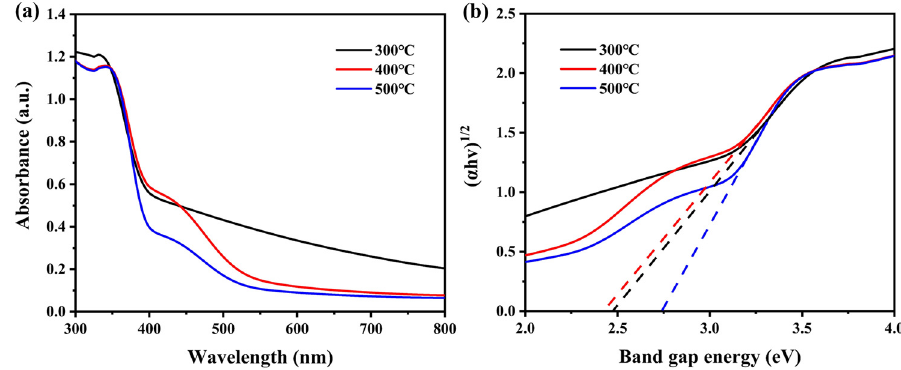
Figure 3. ( a ) UV-visible absorption spectra of N-TiO 2 prepared under three different calcination temperatures. ( b ) The plot of the transformed Kubelka–Munk function versus the wavelength of light.